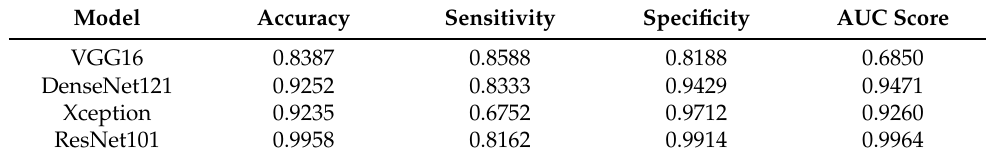
Table 2. Performance metrics 1 on the WSI dataset.